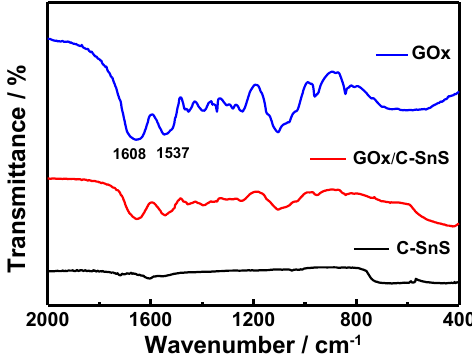
Figure 4. Fourier transform infrared spectroscopy (FTIR) of carbon-coated SnS (C-SnS), glucose oxidase (GO x ), and GO x on C-SnS.